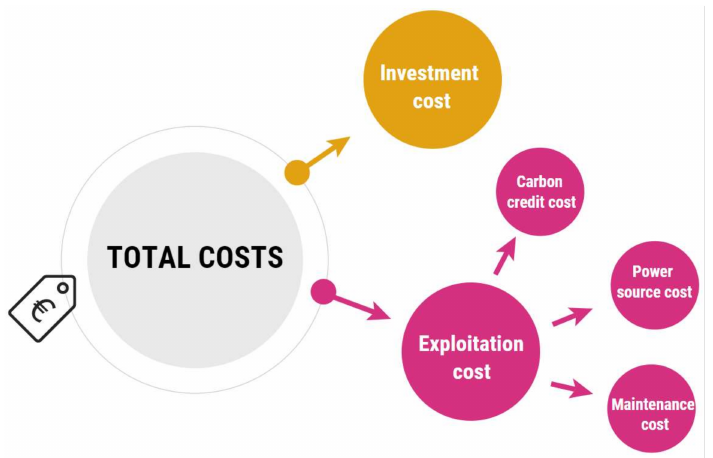
Figure 5. Total costs of a ship power system